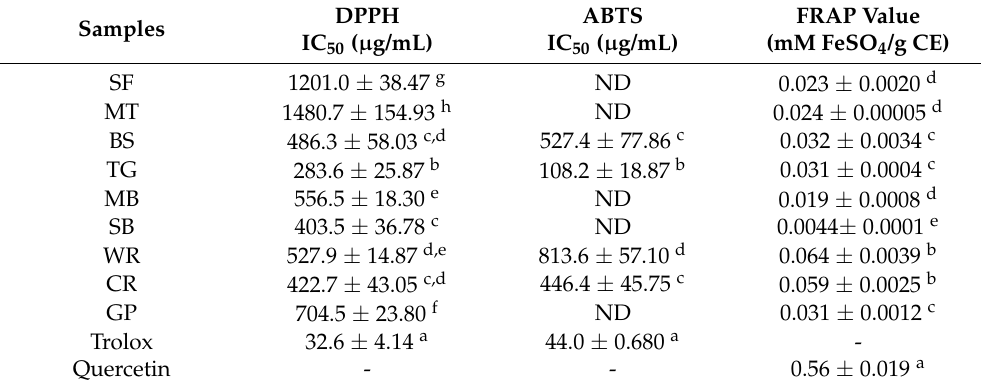
Table 3. Antioxidant activities via DPPH ( n = 4), ABTS scavenging activity, and FRAP assays ( n =